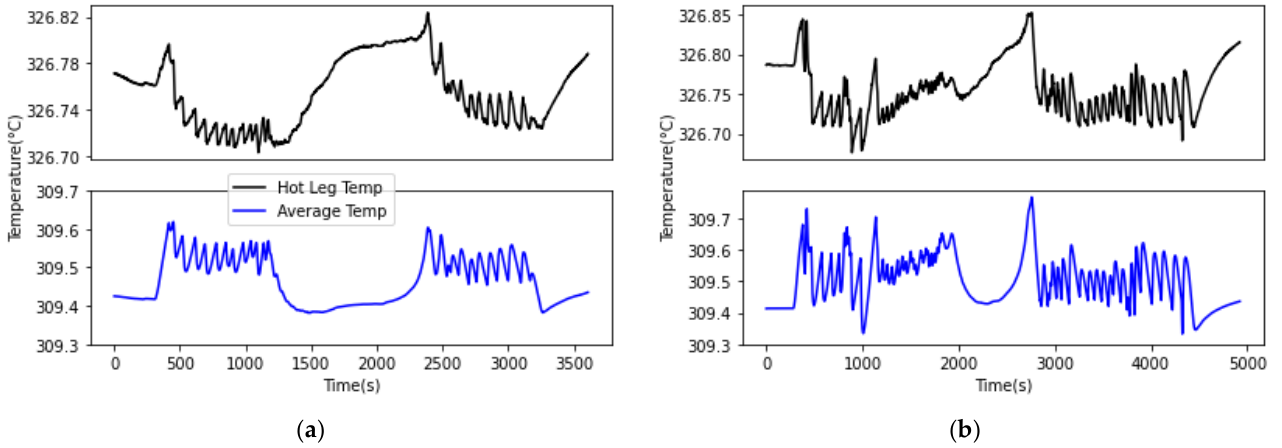
Figure 7. The hot leg and average coolant temperatures in the RCS during the transitions between pure electric power generation and mixed-mode power generation. Results are shown for 15% TPE ( a ) and 50% TPE ( b ). Note that the temperature axis is inverted to match the configuration of Figure 6.